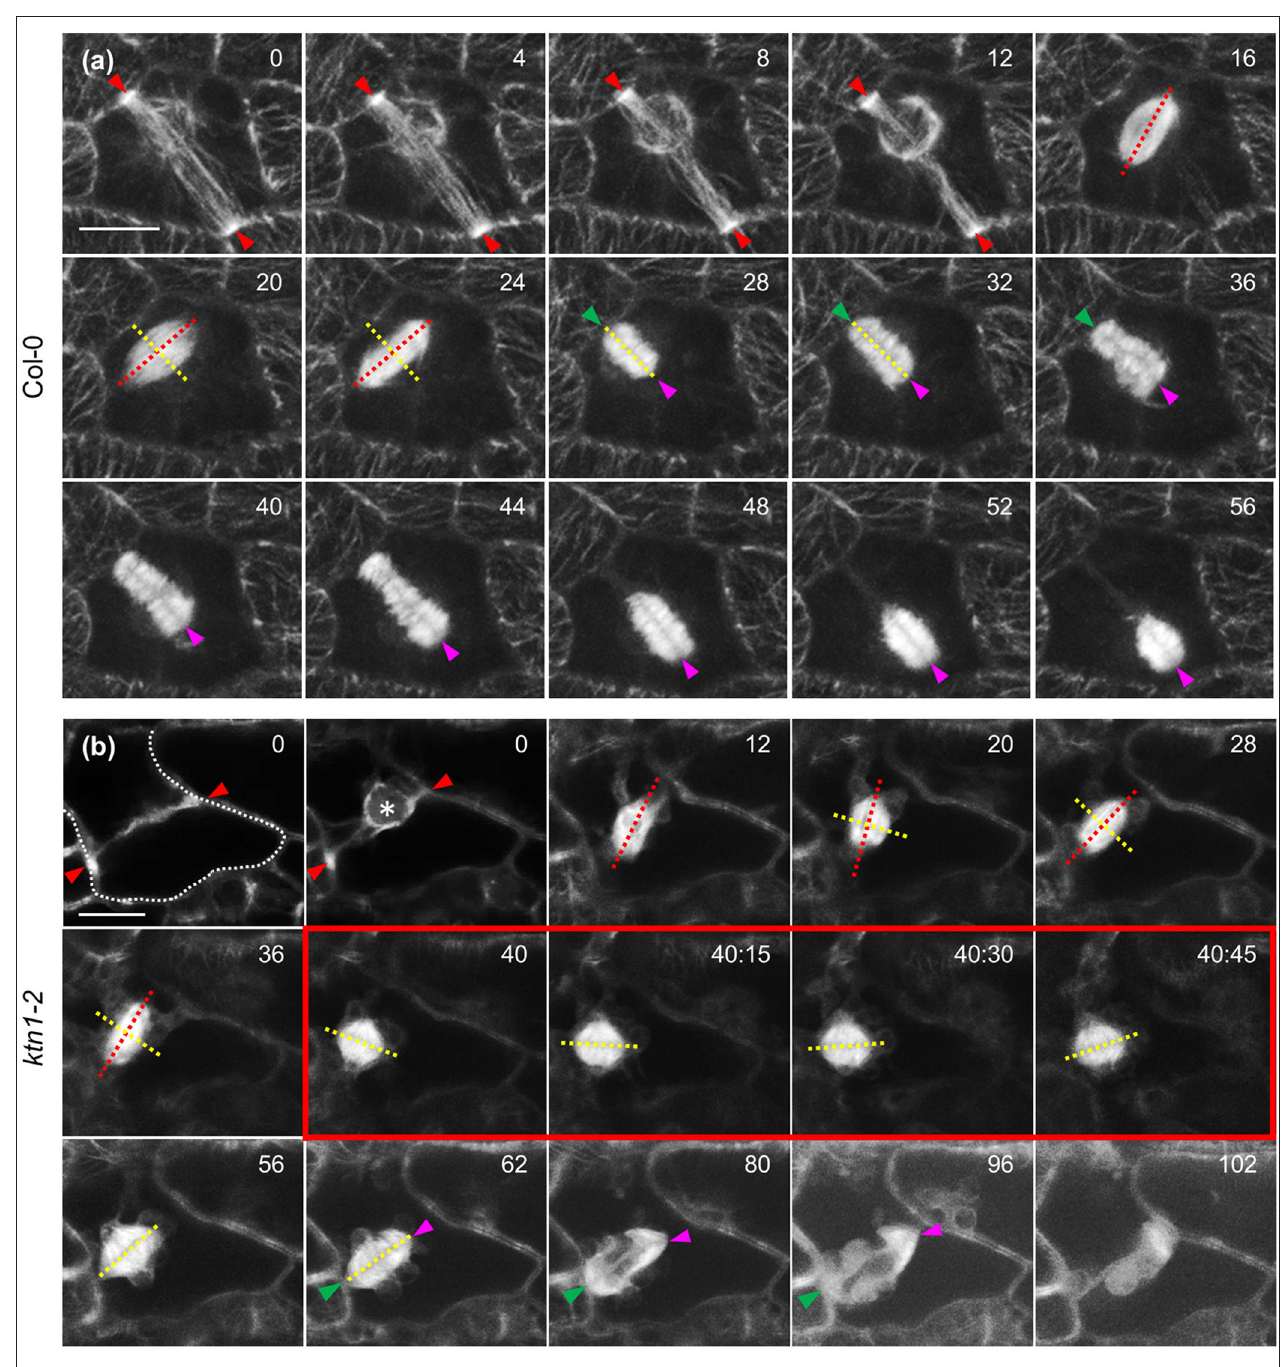
FIGURE 10 | Mitotic and cytokinetic progression in Col-0 and ktn1-2 cotyledon epidermal cells expressing a GFP-TUA6 microtubule marker after Airyscan CLSM imaging. (a) Mitotic spindle and phragmoplast dynamics in Col-0. Mitotic spindle is positioned so that the equatorial plane (yellow line) coincides with the PPB plane (red arrowheads) while the spindle axis (red line) is perpendicular to it. Both the spindle equator and the cell plate (yellow lines) remain coaligned to the CDP. Sometimes the phragmoplast reaches the parent wall asymmetrically creating a stable contact (green arrowhead) while the remaining leading edge (magenta arrowhead) still follows the trajectory predetermined by the PPB. (b) In ktn1-2 the mitotic spindle equator (yellow line) is not adhering to the predetermined CDP (red arrowheads) and the spindle rotates significantly (spindle axis indicated by red line). Subsequently the nascent phragmoplast rotates as well until one end is attracted and tethered to the parent wall (green arrowhead). After this positional correction, the phragmoplast leading edge (magenta arrowhead) strictly follows the plane determined by the PPB so that the cell plate will coincide with the predetermined CDP. It is notable that progressively microtubules at the phragmoplast margin assume the “arrowhead” configuration as shown before (frames 80 and 96min; Panteris et al., 2011). Scale Bars: 5 µ m. Numbers in (a,b) correspond to time (min:s).